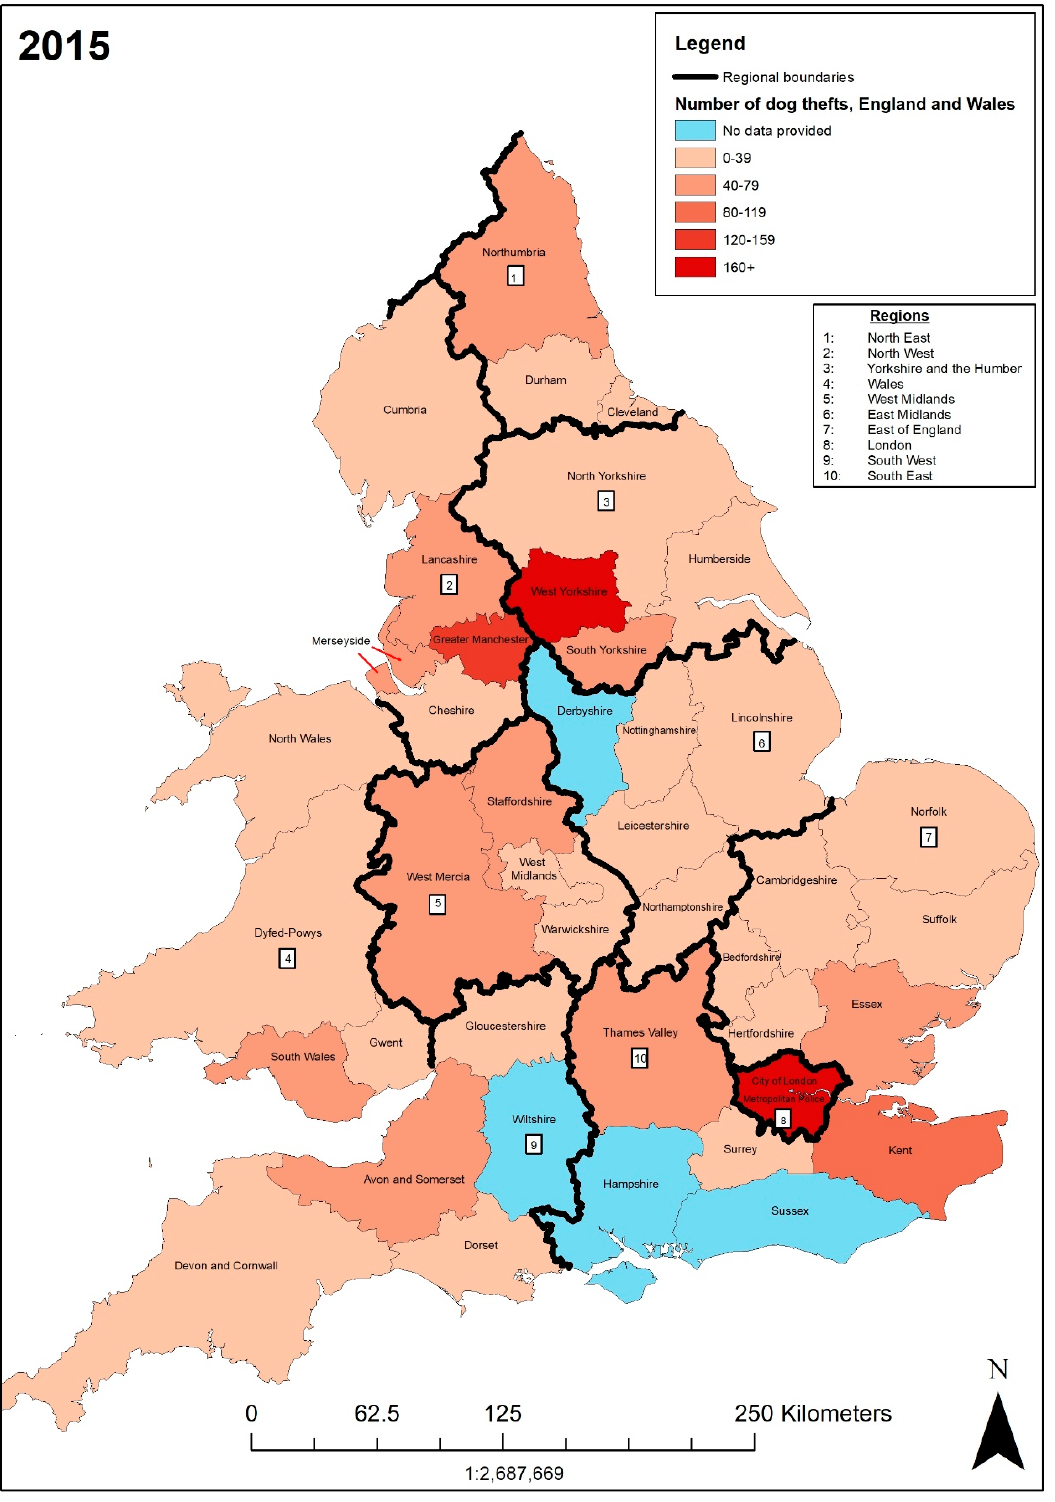
Figure 2. Number of dog theft crimes recorded by each police force in England and Wales in